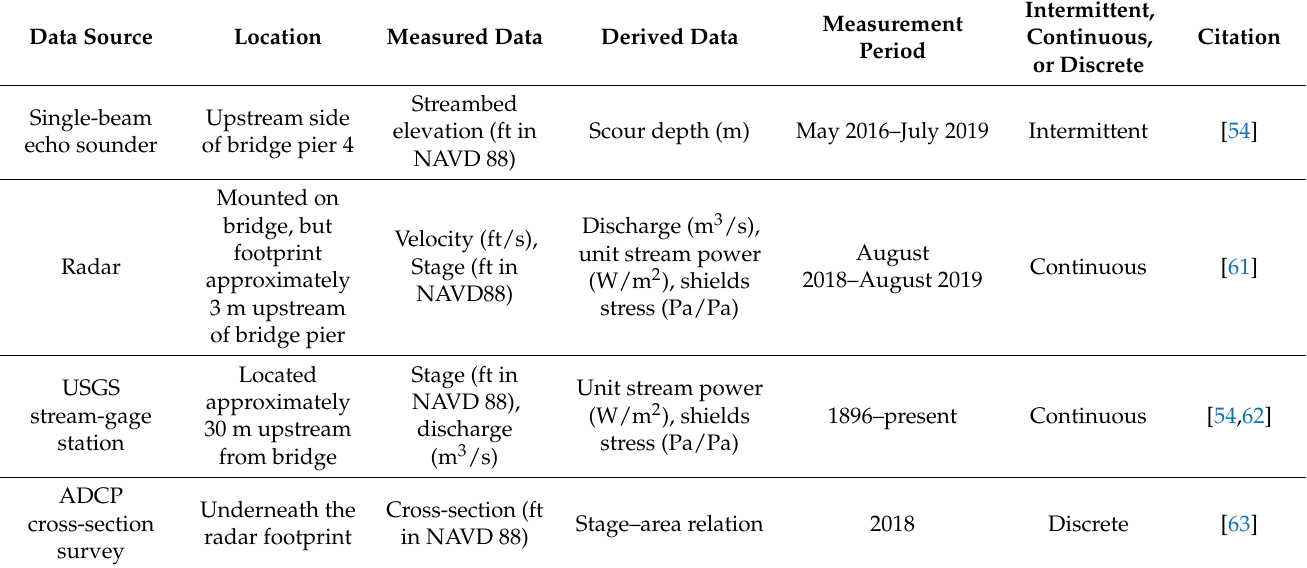
Table 1. Overview of data collected, including instrumentation, measurements, and measurement time